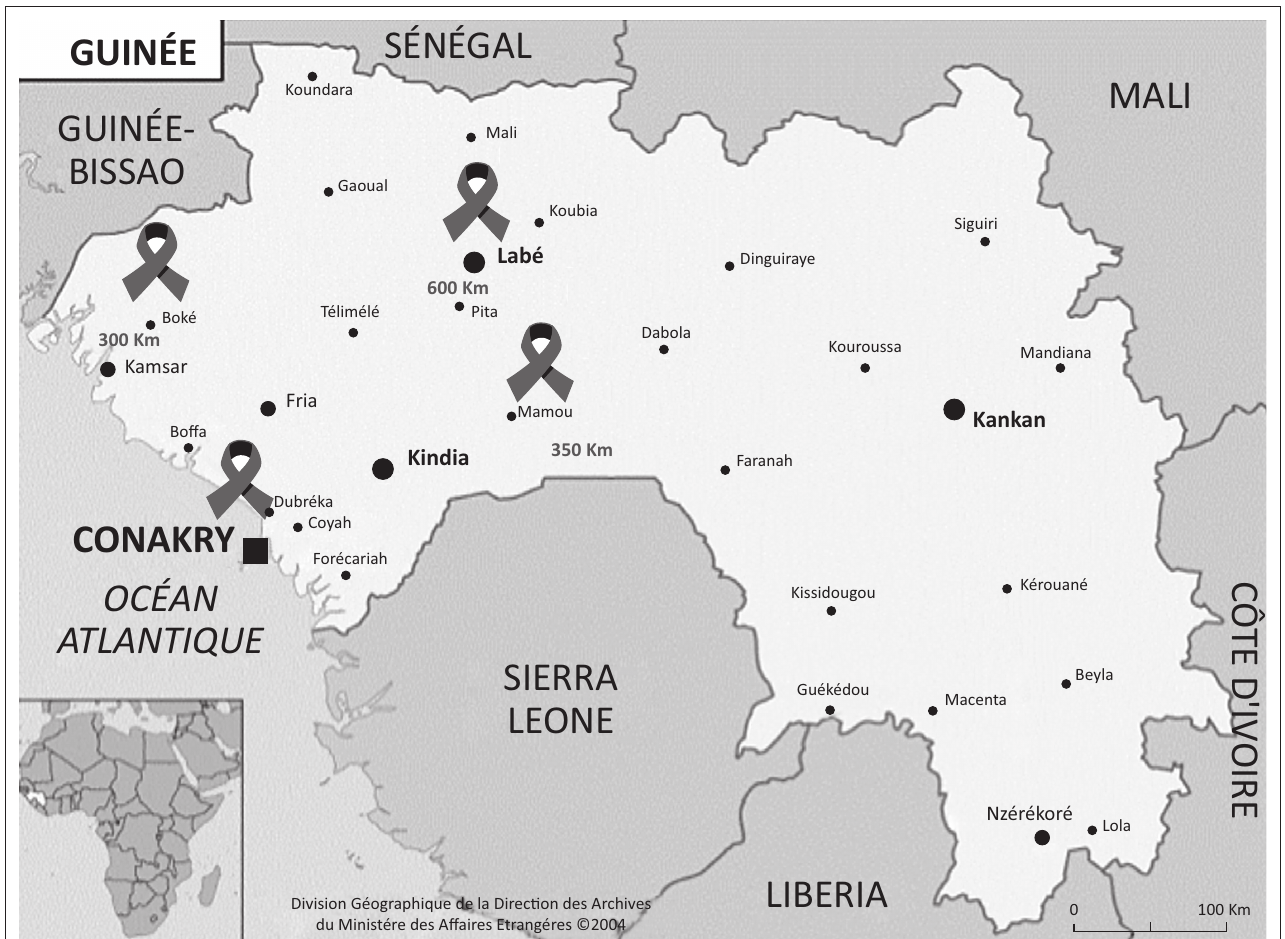
FIGURE 1: Répartition des sites de collecte des